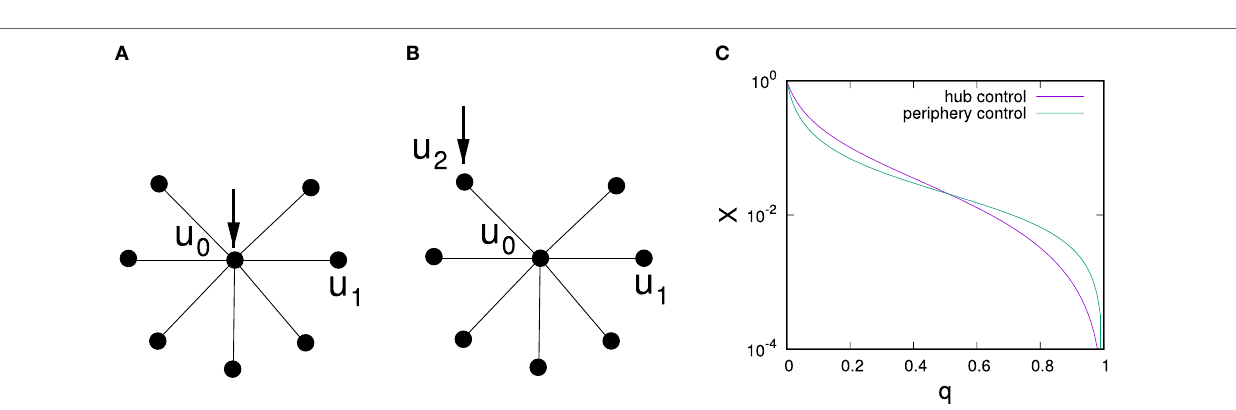
FIGURE 6 | Illustration of a star network with control targeted at a central hub (A) and control targeted at a periphery node (B) and dependence of the average stationary vote shares for both scenarios on q (C) for a star network with one central hub and k = 15 spokes. Average probabilities of being in the controlled state are labeled u 0 for the hub node, u 1 for uncontrolled periphery nodes, and u 2 for a controlled periphery node.